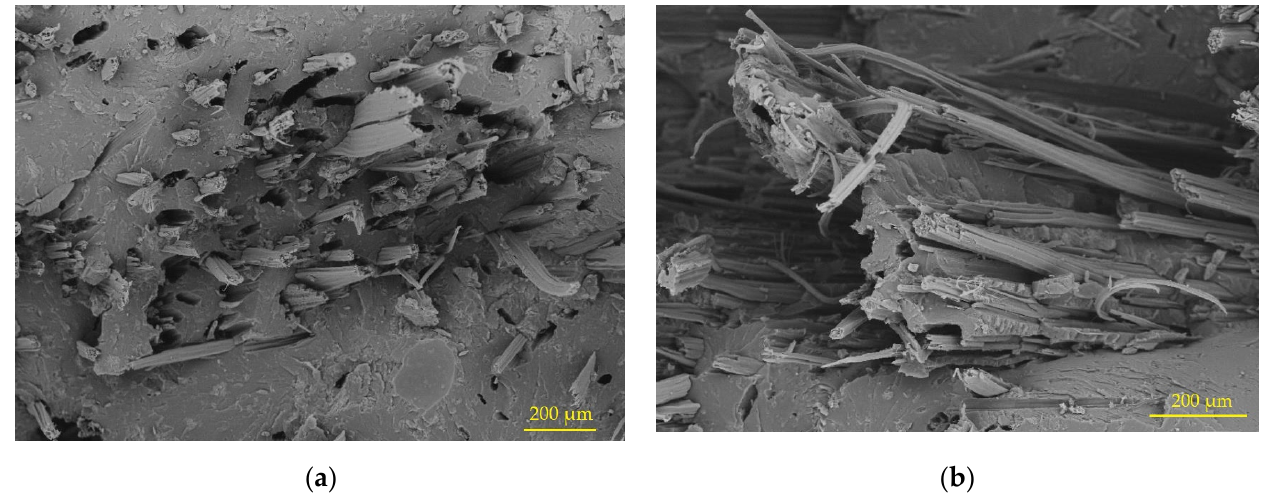
Figure 6. Scanning electron microscopy (SEM) in the tensile test specimen fracture zone: ( a ) sample PPH25, 146×; ( b ) sample PPH20, 200×.